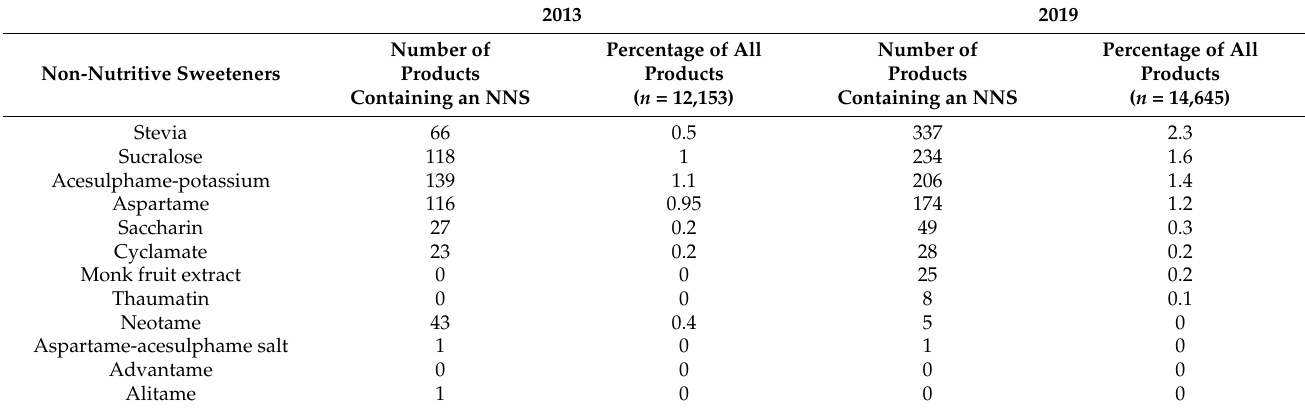
Table 3. Number and percentage of the total number of products containing each NNS in 2013 and 2019